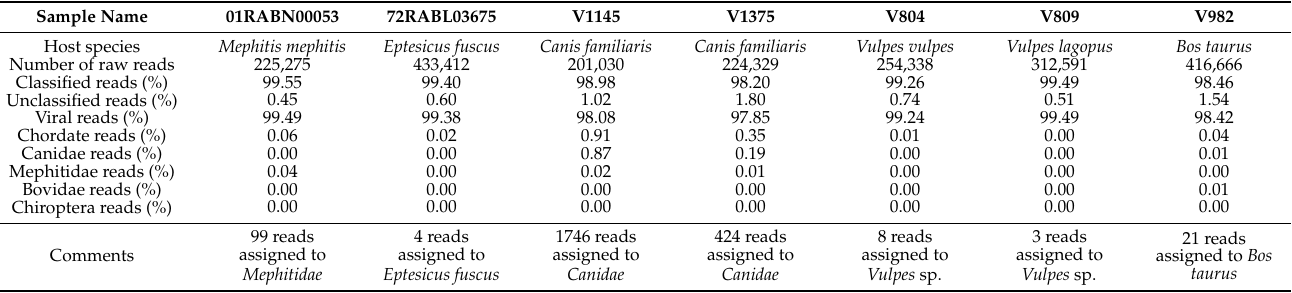
Table 1. Species assignment of raw Illumina reads by Kraken2.